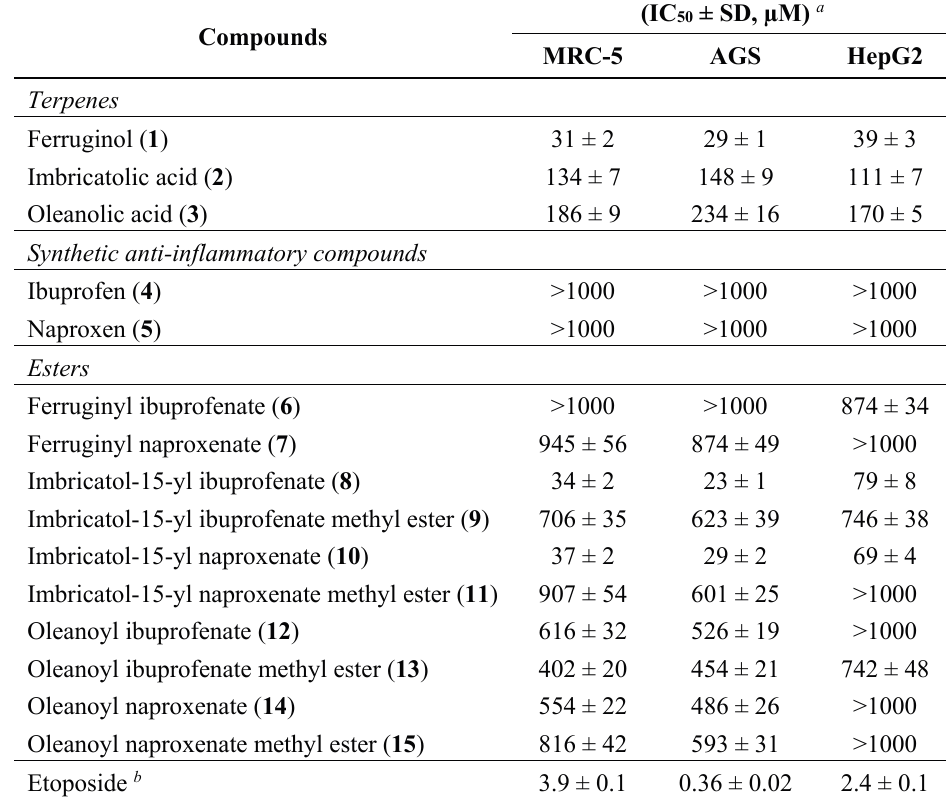
Table 2. Cytotoxicity of compounds 1 – 15 towards confluent cultures of three human cell lines: lung fibroblasts (MRC-5), gastric epithelial cells (AGS) and hepatocytes Hep